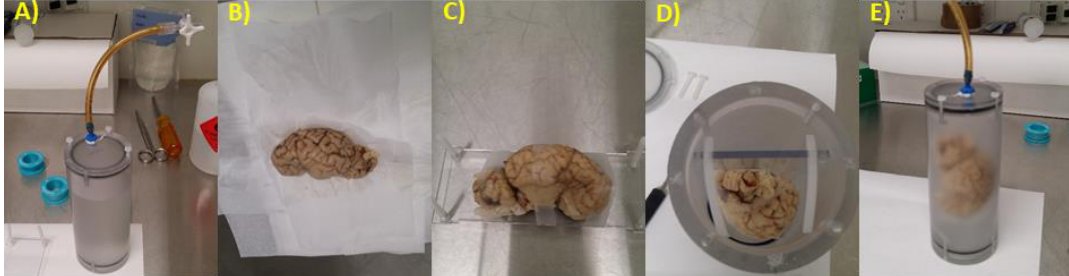
Figure 1. Brain tissue preparation for MRI acquisition. ( A ) The custom-made chamber has a tight seal which is secured with plastic screws. The lid has a tube attached to a 3-way tap to allow de-gassing. ( B ) The brain is patted dry with Kimwipes ® (Kimberly-Clark), until no more water is present on